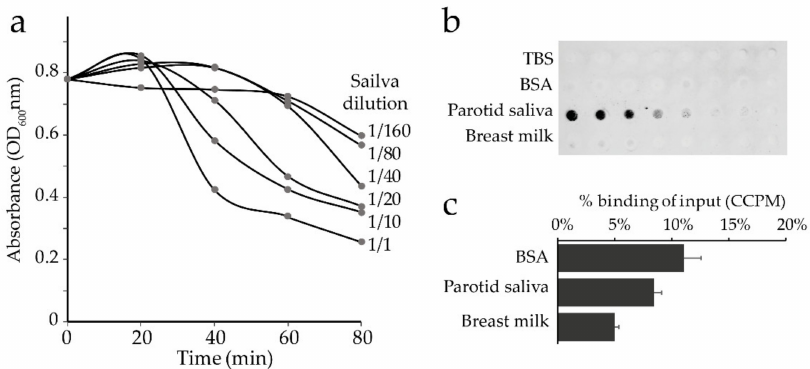
Figure 2. Saliva and breast milk aggregation and adhesion of C. matruchotii . ( a ) Sedimentation assay of aggregation in parotid saliva by time and ( b ) binding of Tris-base-saline bu ff er (TBS) (Ctrl), bovine serum albumin (BSA, 2.5 mg to 0.020 mg per mL TBS), pooled parotid saliva (diluted 1:2, 1:4, 1:8, 1:16,